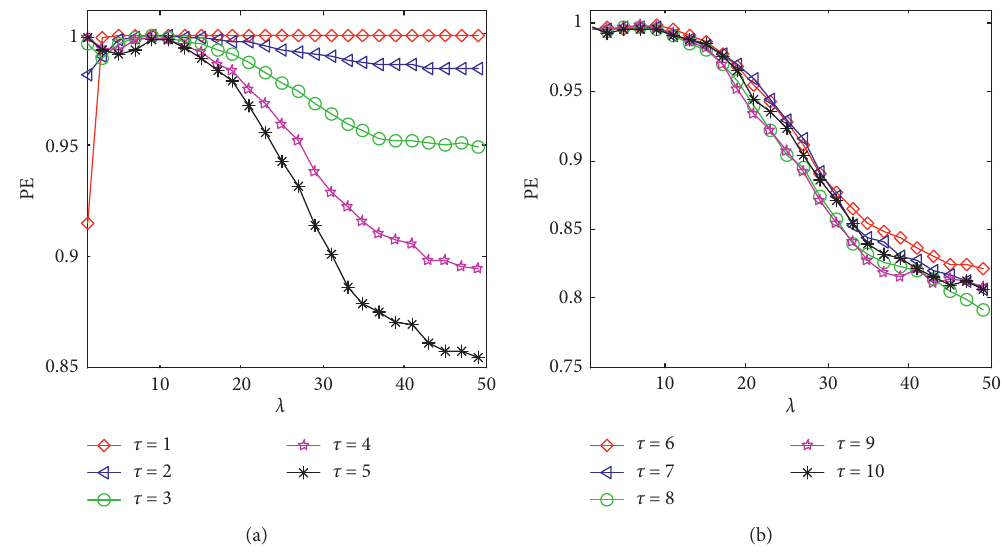
Figure 6: The MPE of morphological filter residuals: (a) τ � 1 , 2 , ... , 5; (b) τ � 6 , 7 , ... ,